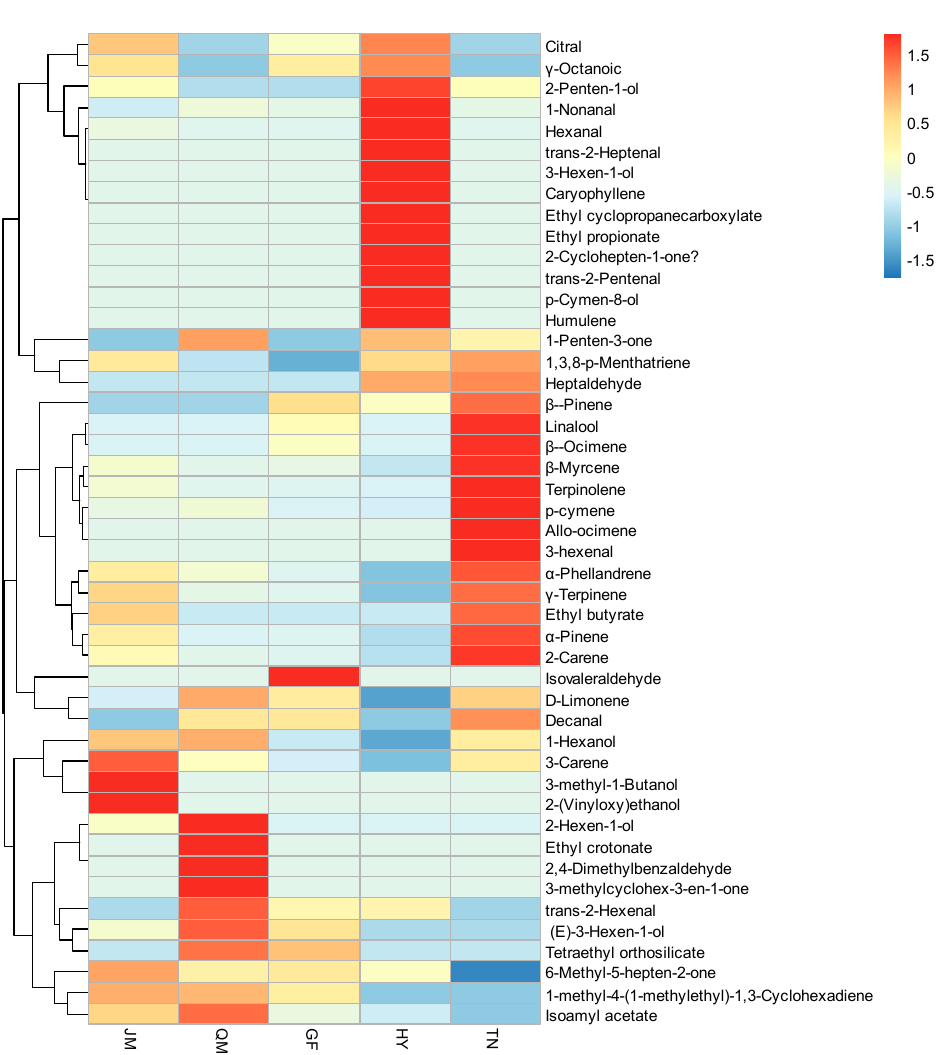
Figure 4. Hierarchical clustering of the all compounds in different mango samples.